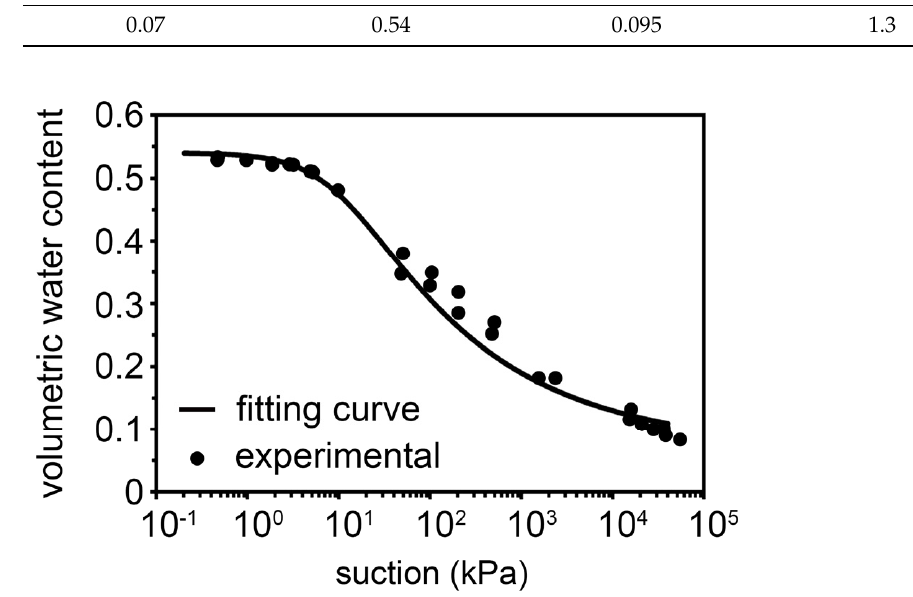
Figure 6. Comparison between the theoretical retention curve (Equation (22)) and some experimental data obtained from laboratory tests (modified from [50]).